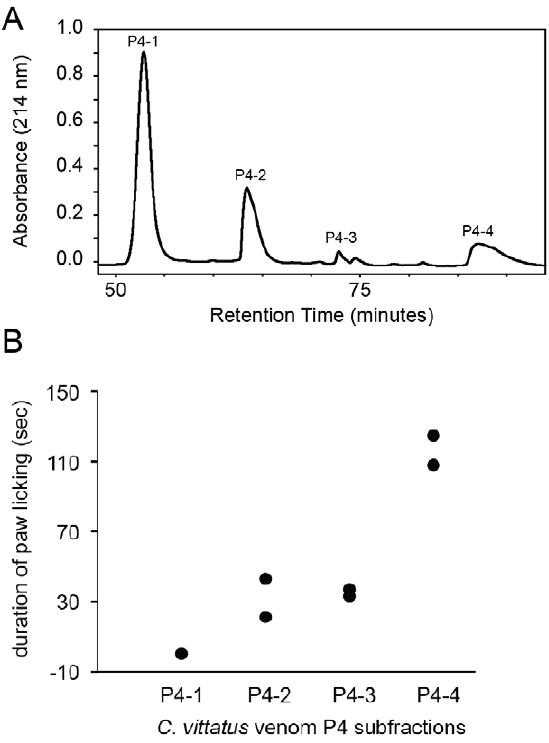
Figure 3. Effect of C.vittatus venom P4 subfractions on paw- licking behavior in Mus musculus . A. High performance liquid chromatography (HPLC) profile of C. vittatus venom P4 subfractions. Fraction P4 was separated into four subfractions (P4-1, P4-2, P4-3, P4-4). B. Duration of hind-paw licking by M. musculus injected with C. vittatus P4 subfractions. Each sample was tested on two mice and each mouse was injected only once. Paw licking was recorded for five minutes following the injection. The paw licking values from both the first and second tests are shown in plot. Note, values for the first and second tests for P4-1 are identical and markers